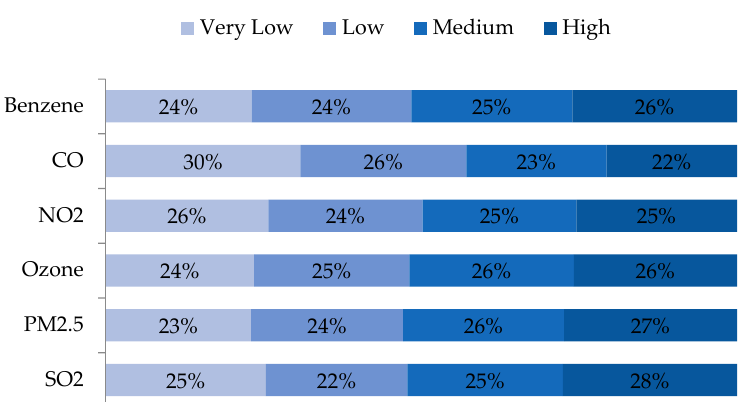
Figure 8. Distribution of exposure category based on WA metrics, for all observations with ambient air measurements indicating ‘Low’ exposure, by pollutant.